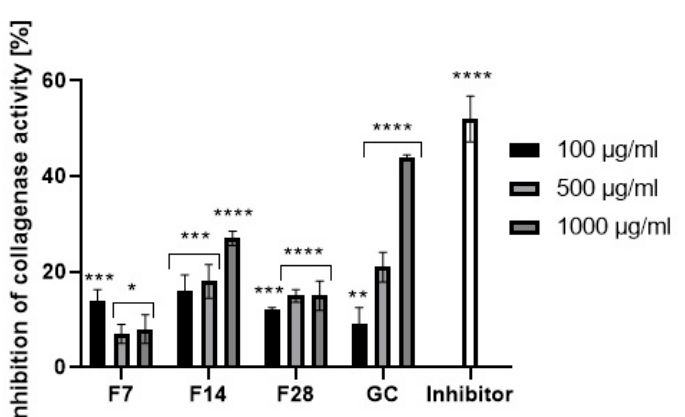
Figure 11. Collagenase inhibitory activity of coffee beans and kombucha ferments . Data are the mean of three independent experiments, each consisting of two replicates per treatment group. **** p < 0.0001, *** p < 0.0002, ** p < 0.02, * p < 0.01.